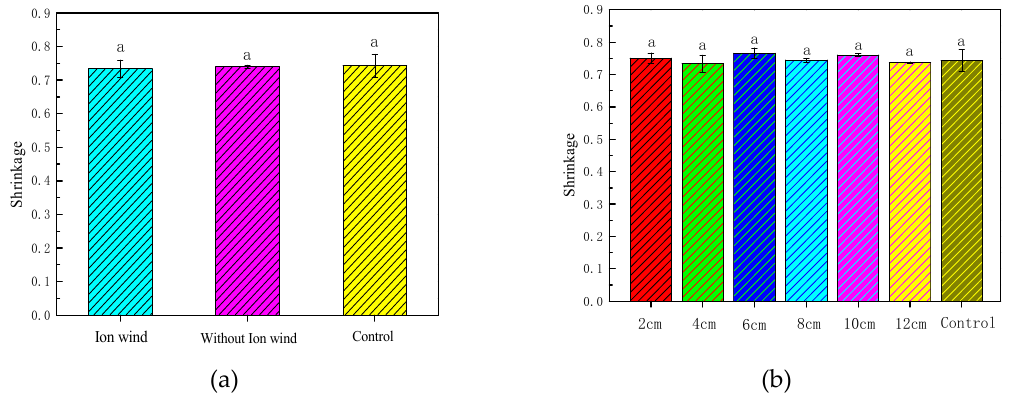
Figure 6. The shrinkage rate of Chinese wolfberry fruits. ( a ) Ionic wind and without ionic wind; ( b ) different needle spacing. Data are shown as the mean ± SD. For each response, means with different lower-case letters are significantly different ( p < 0.05).